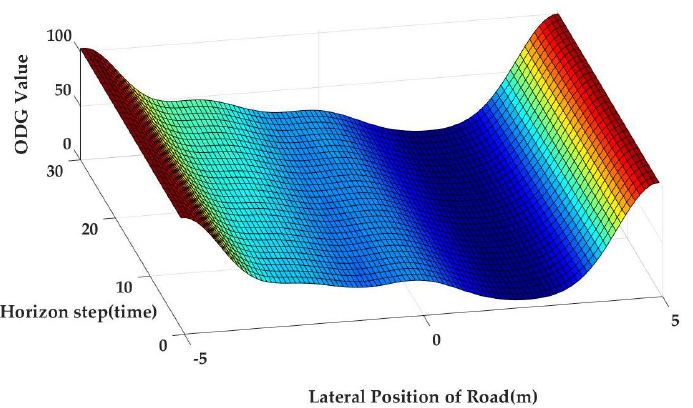
Figure 13. Total obstacle-dependent Gaussian (ODG) with model prediction control longitudinal